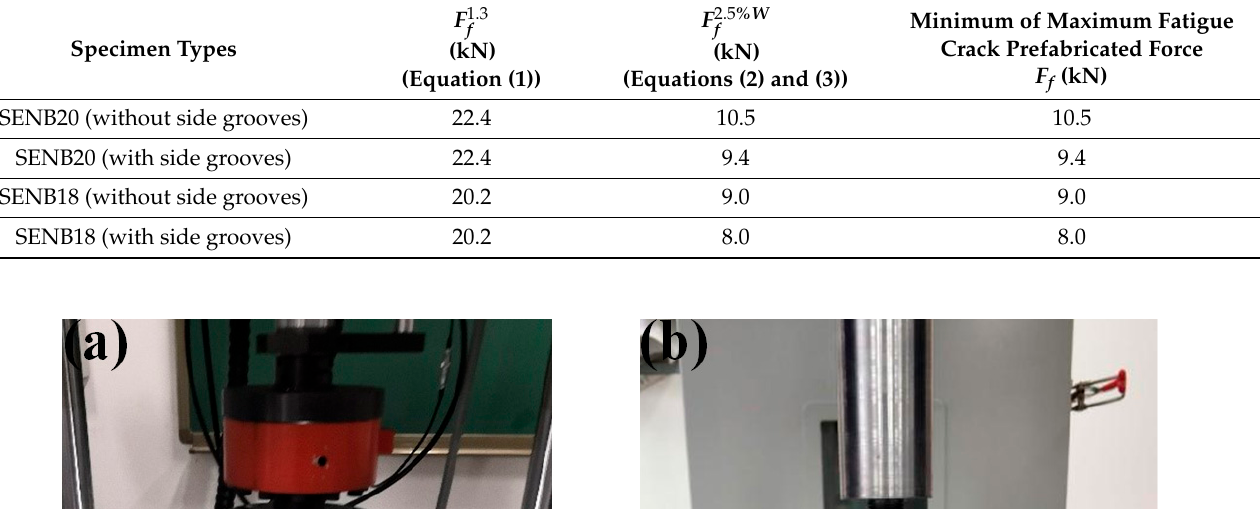
Table 4. Maximum fatigue crack prefabricated forces of four specimens.